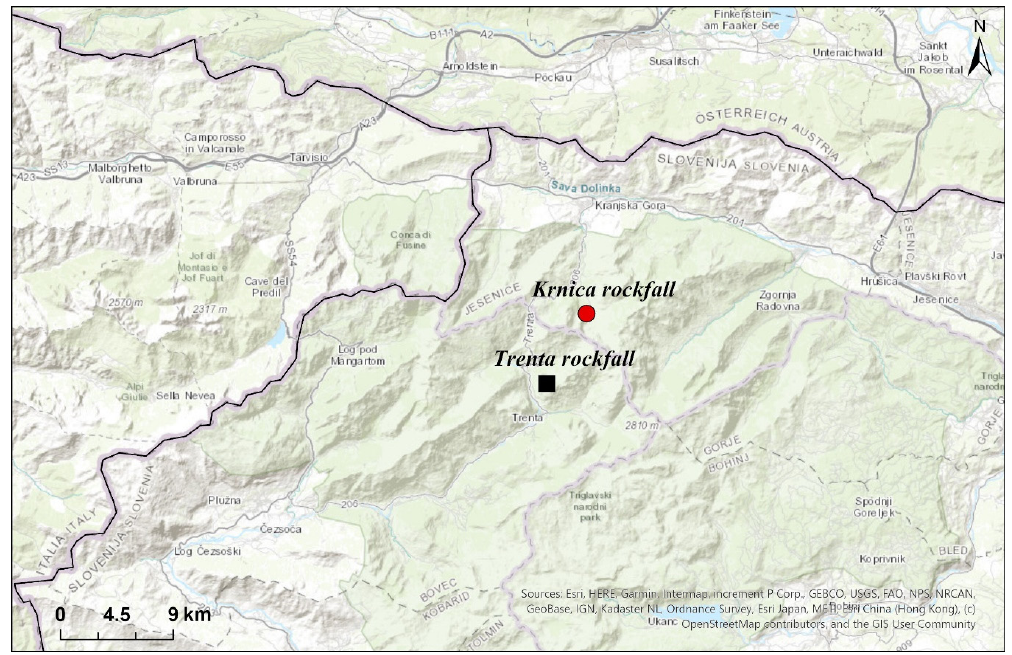
Figure 10. The tested rockfalls are located in the north-western part of Slovenia, in the Julian Alps, near the Italian–Austrian border.